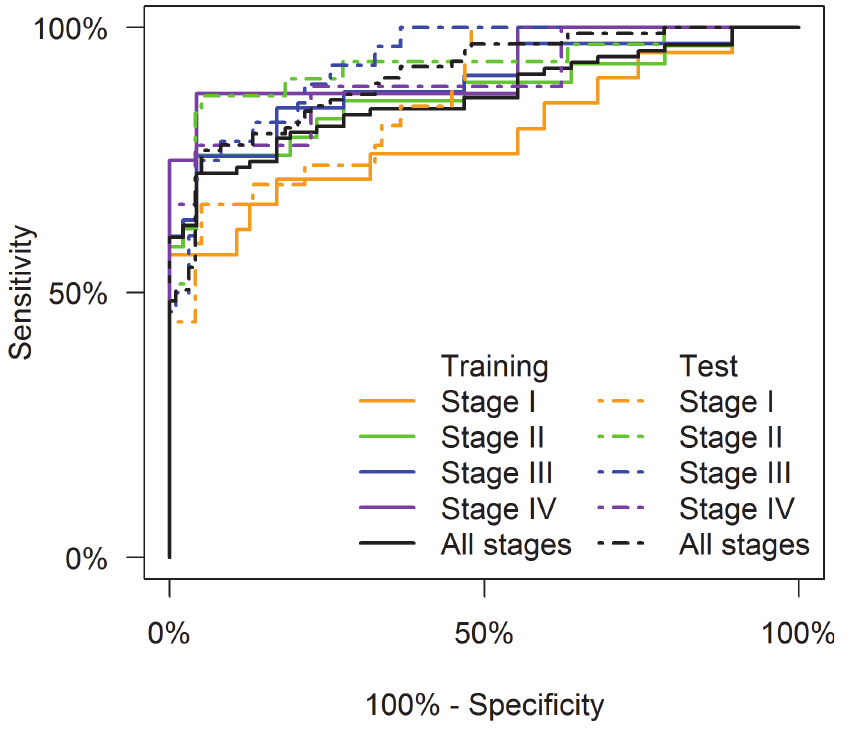
Fig 1. Receiver operator characteristic (ROC) curves by AJCC TNM stage for the three biomarker model, fitted to the training data, and applied to both training and test data.